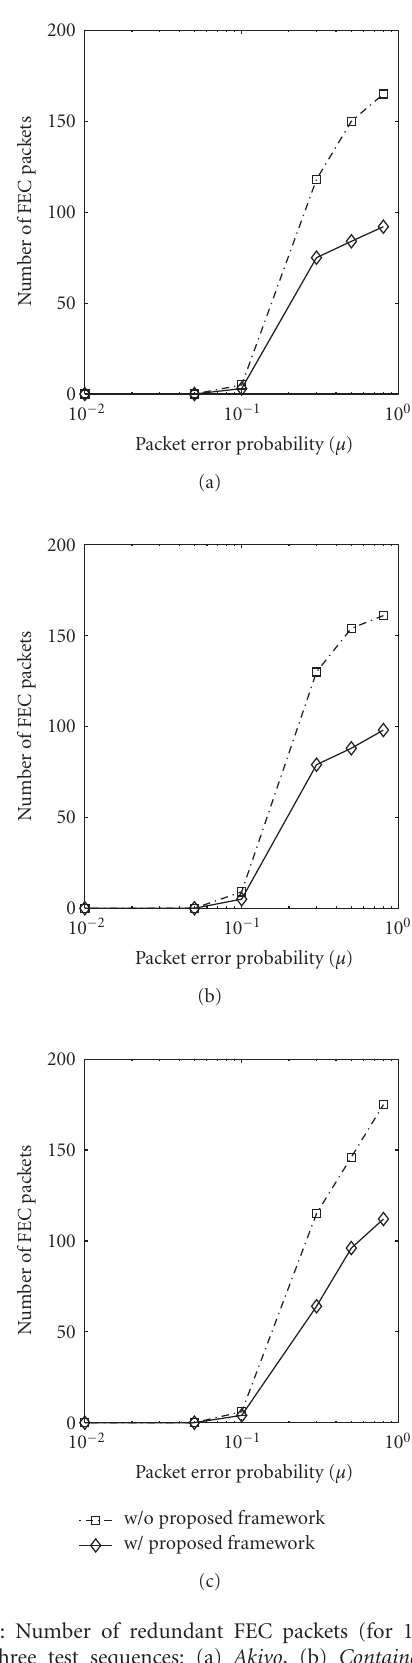
Figure 5: Number of redundant FEC packets (for 100 frames) for the three test sequences: (a) Akiyo , (b) Container , and (c) Foreman